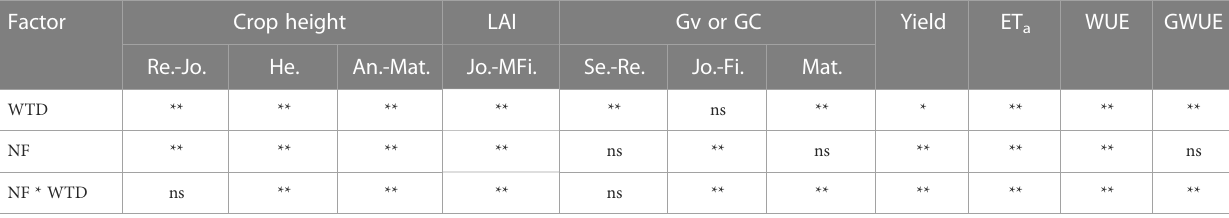
TABLE 3 Two-way ANOVA of crop height, leaf area index (LAI), yield, and water utilization in winter